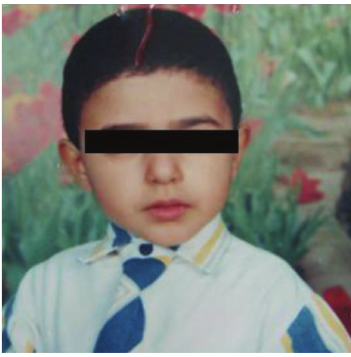
Figure 1: The phenotype of the patient.